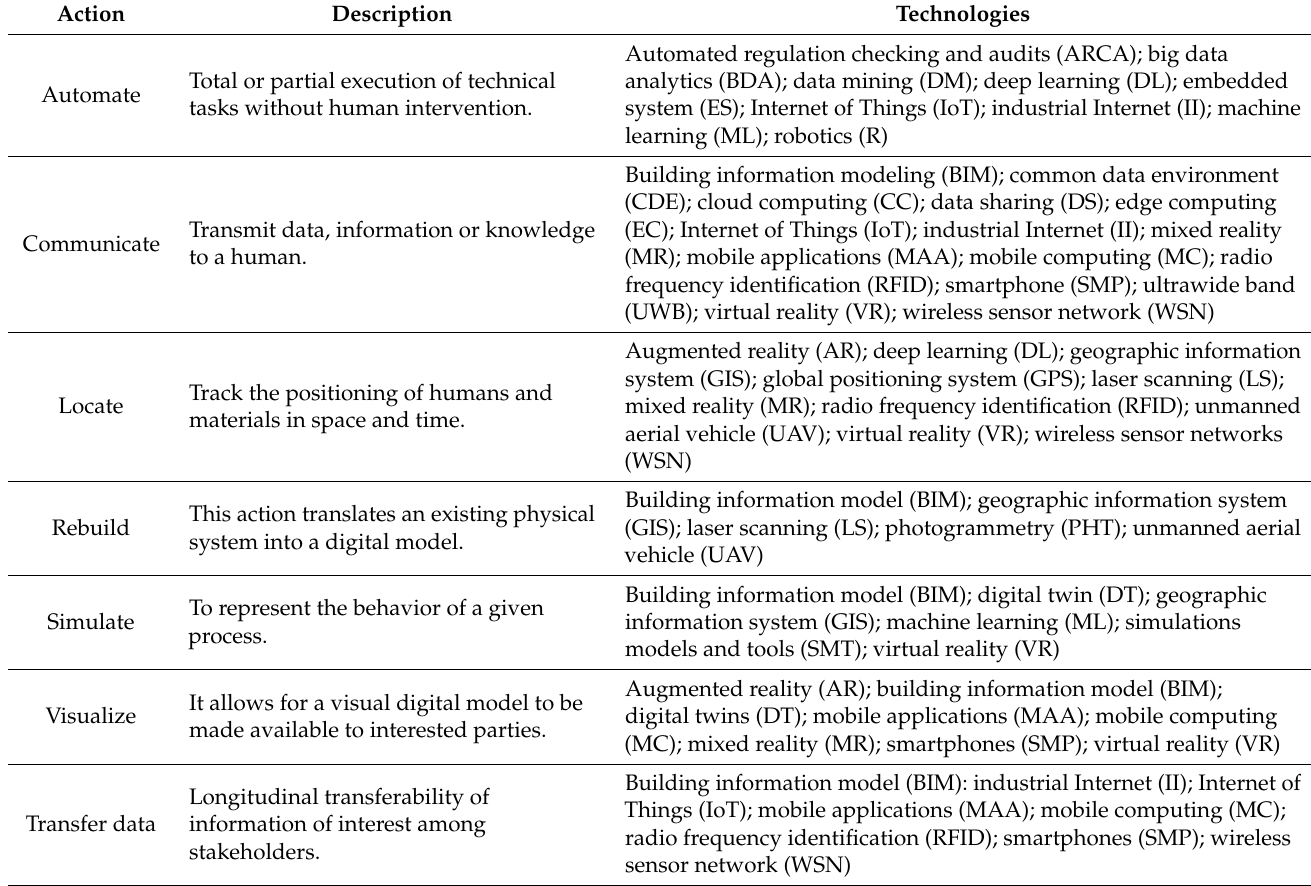
Table 7. Actions associated with the technologies applied during the construction phase: monitoring and control. Construc- tion 4.0. Adapted from